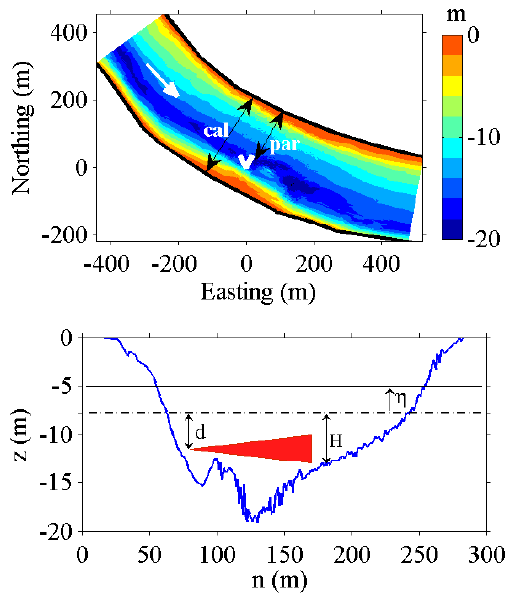
Fig. 2. Top: bathymetry at Melak discharge gauging station. The arrow indicates flow direction, V indicates the location where the H-ADCP was deployed, double arrows indicate locations of boat- mounted ADCP transects. Bottom: channel cross-sectional profile at the station. The shaded area indicates cross-section of the H- ADCP conical measuring volume, d is the distance of the H-ADCP below the mean water level, H is mean water depth, η is water level variation, and z is normal distance from the